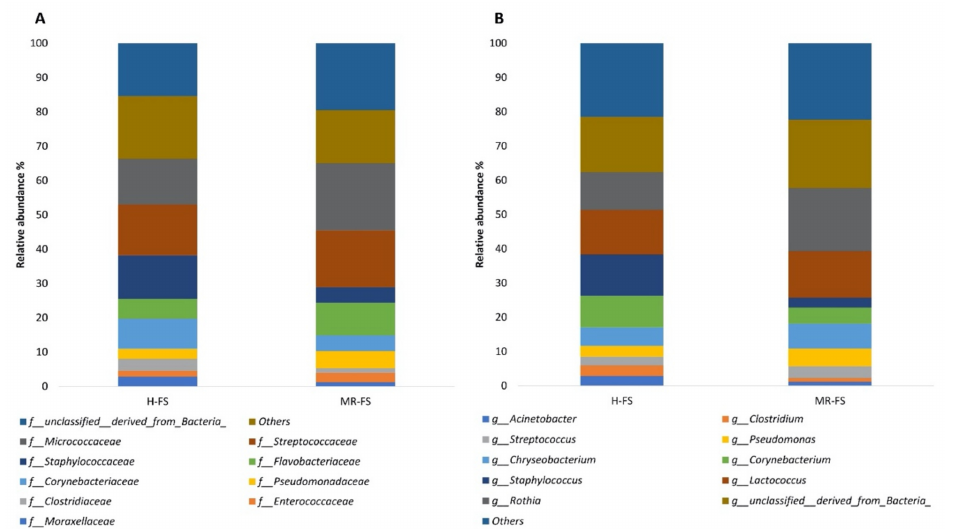
Figure 5. Relative abundance of Top-ten OTUs at the genus ( A ) and family ( B ) level.